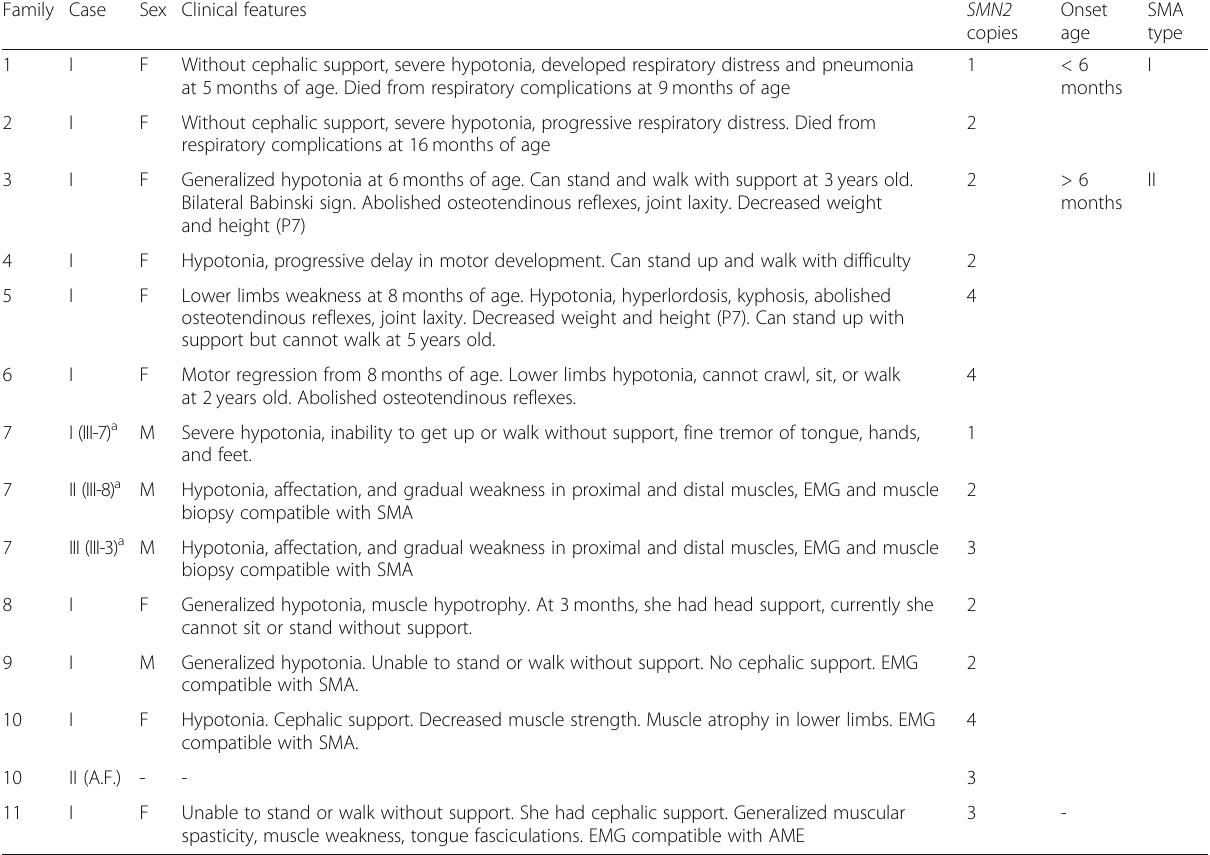
Table 3 Genotype-phenotype correlation in index cases homozygous for SMN1 deletion Family